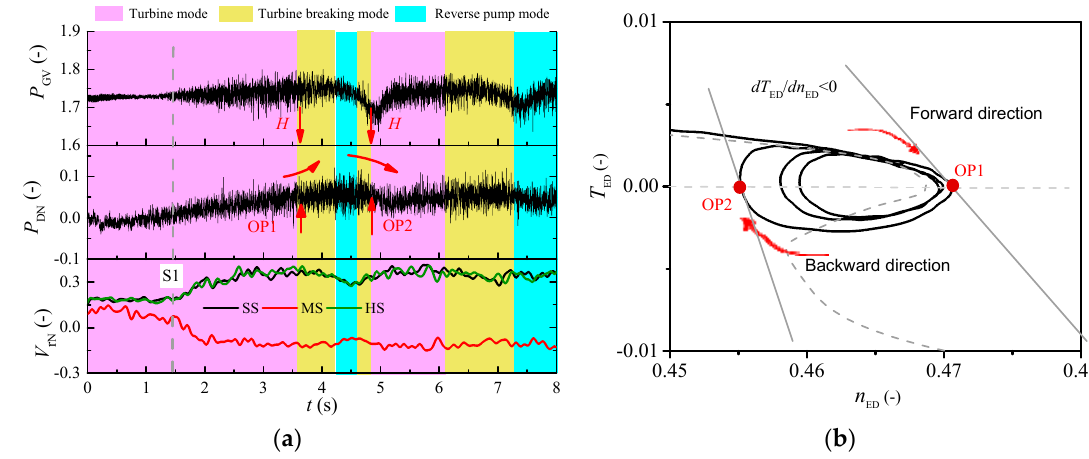
Figure 6. Dynamic trajectories and time histories of operating parameters at GVO 6°. ( a ) Variation of pressure and radial velocity; ( b ) dynamic trajectories.